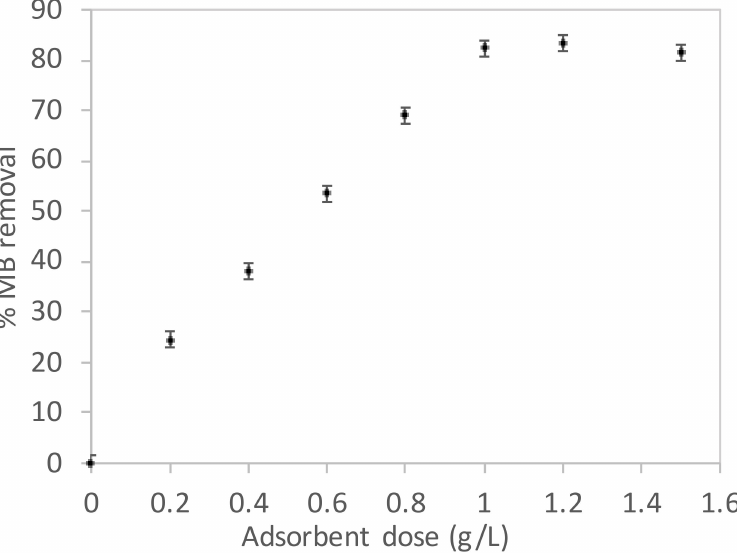
Figure 7. The adsorbent dose effect for the %MB removal (100 mL of solution with 50 ppm of MB, pH = 6.0, system was stirred at 150 rpm and kept at 289 K for 3